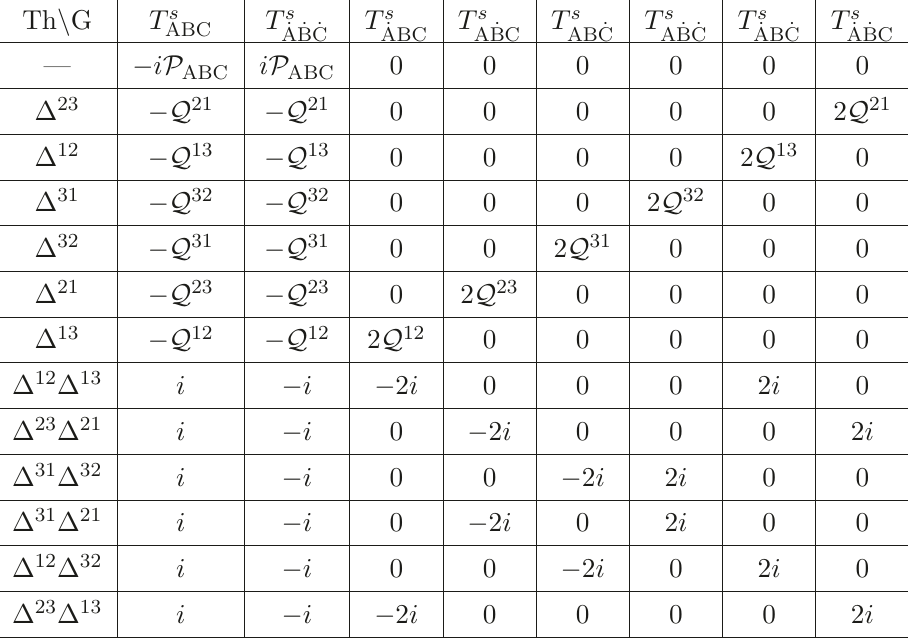
Table 2 . Threshold decomposition of the